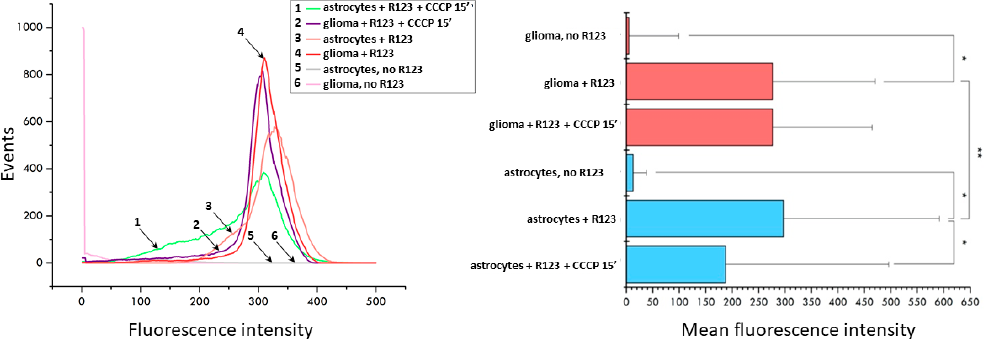
Figure 2. Uncoupler-induced changes in fluorescence of Rh123-stained astrocytes and glioma cells evaluated by flow cytometry. Left panel, distribution of fluorescence (1, green, astrocytes incubated with 2 µM Rh123 and 10 µM CCCP; 2, purple, glioma cells incubated with Rh123 and CCCP for 15 min; 3, pink, as in 1 but without CCCP; 4, red, as in 2 but without CCCP; 5, grey, astrocytes, no additions; 6, light pink glioma, no additions). Right panel, mean fluorescence of Rh123 based on data showing in left panel. * p < 0.05 according to the Wilcoxon criterion, ** p < 0.05 according to the Mann-Whitney U-test.